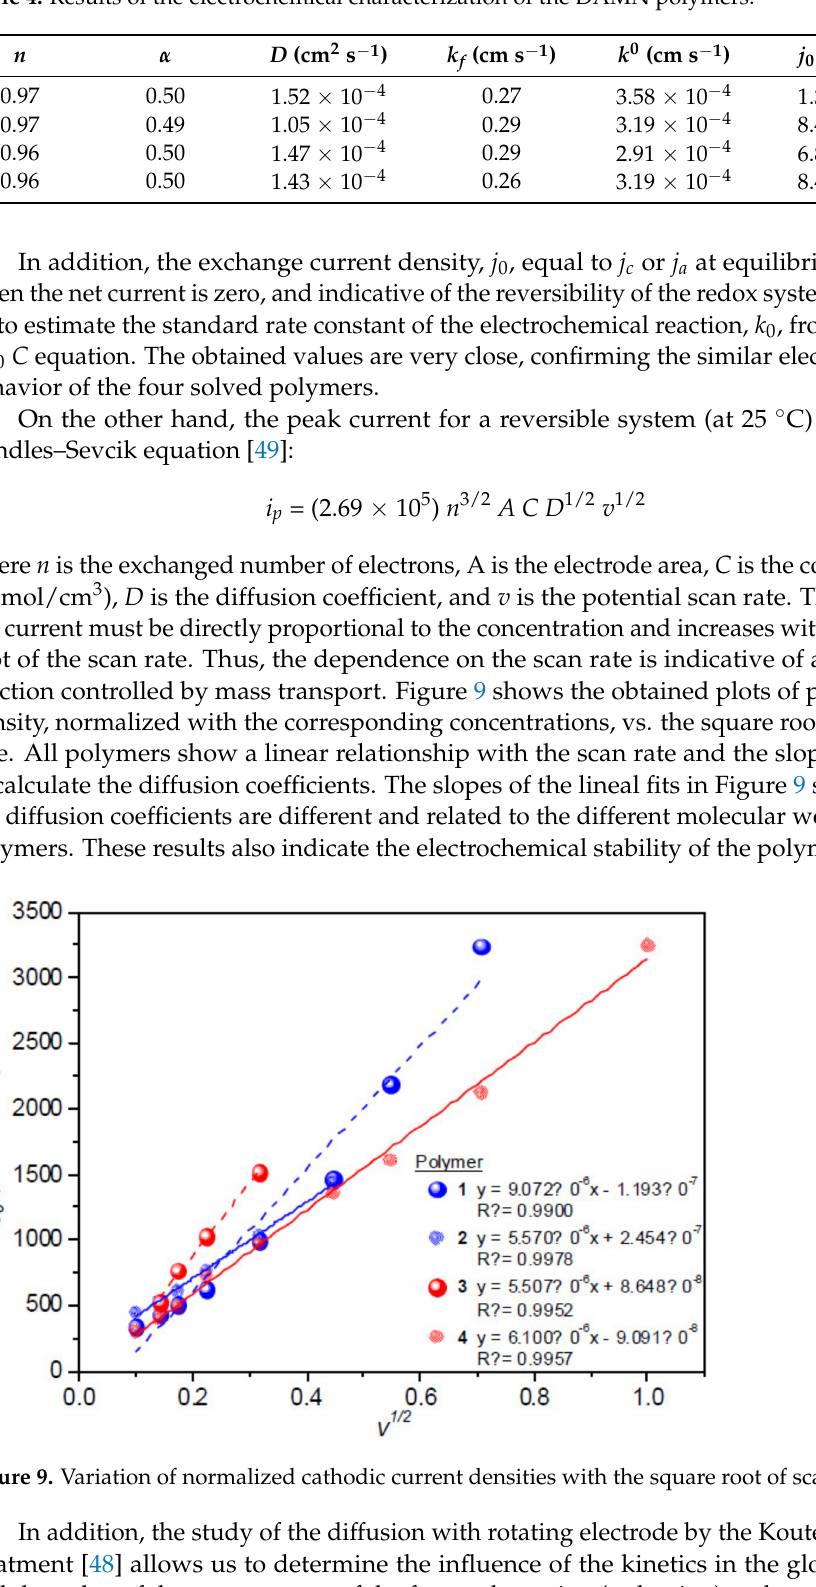
Table 4. Results of the electrochemical characterization of the DAMN polymers.